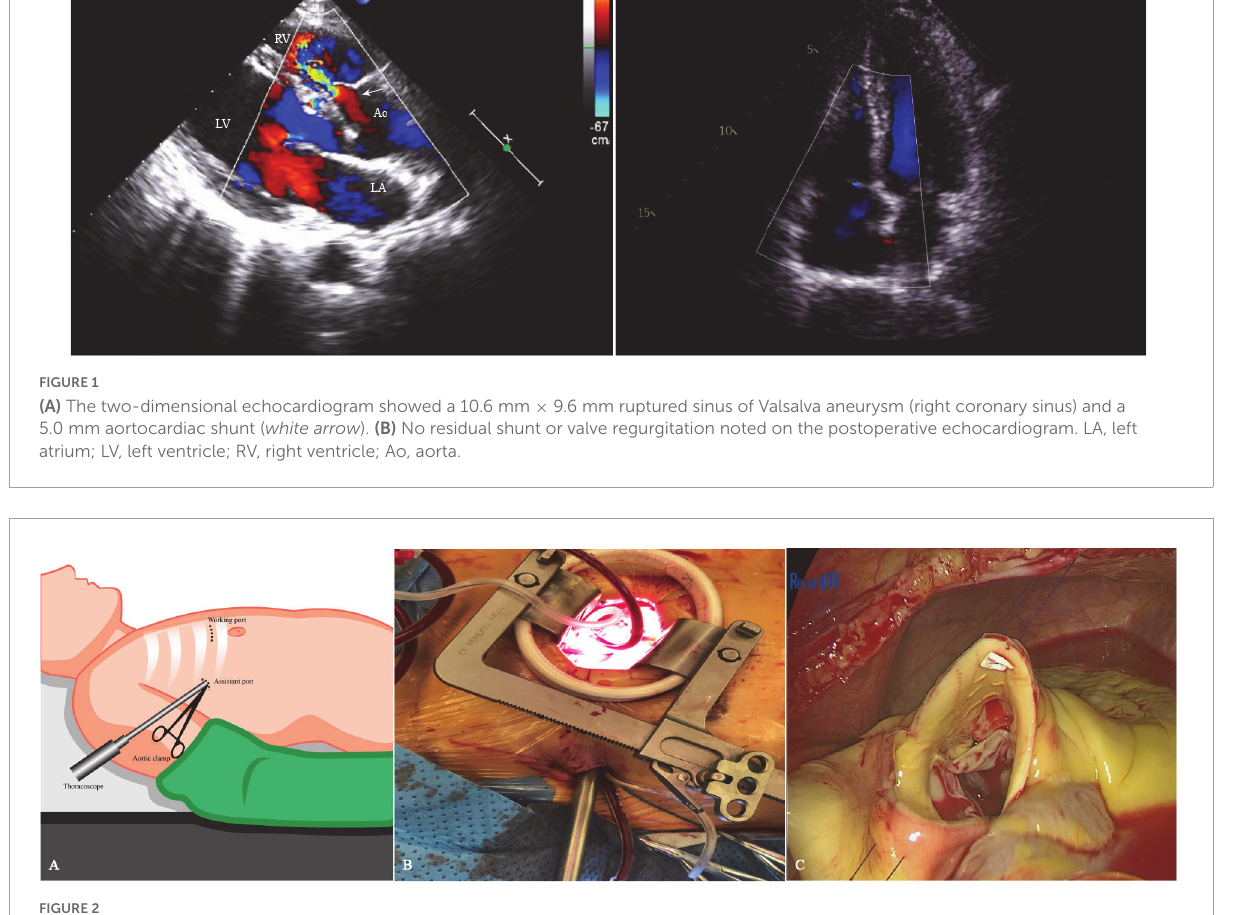
FIGURE2 Schematic diagram of the thoracoscopic procedure. (A) The patient was positioned in a supine position with the right chest elevated by 15 degrees. The working port was placed at the third intercostal space on the mid-clavicular line, while the thoracoscopic port was made in the third intercostal space at the level of the anterior axillary line. (B) Thoracoscopic approach view. (C) To fully expose the aortic root, two or three retraction sutures were placed over the transected